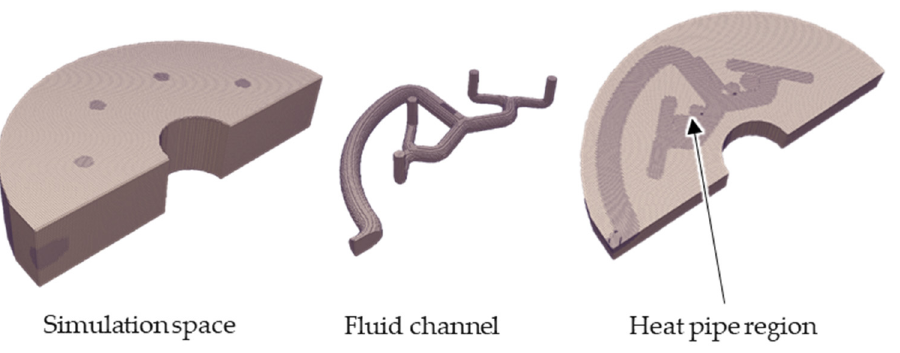
Figure 5. Meshed simulation space and flow channel geometry.